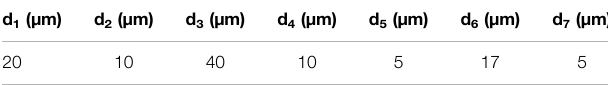
TABLE 1 | Distances d 1 , d 2 , d 3 , d 4 , d 5 , d 6 , and d 7 considered in the design of the multistable